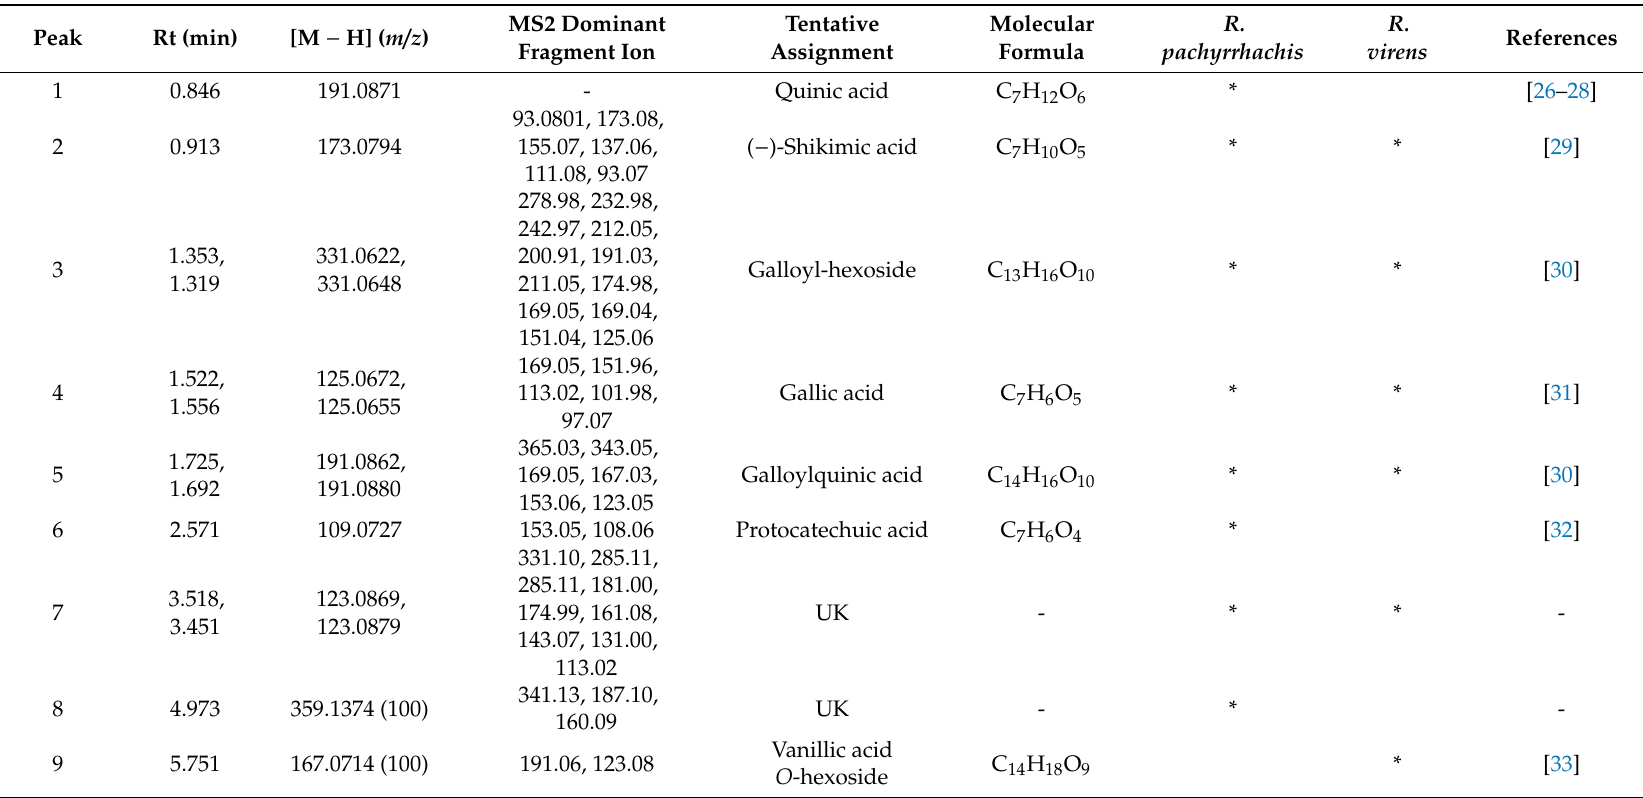
Table 3. Compounds from Rhus pachyrrhachis and Rhus virens identified by UPLC–Mse (Ultra performance liquid chromatography–mass spectrometry elevated energy). Peak